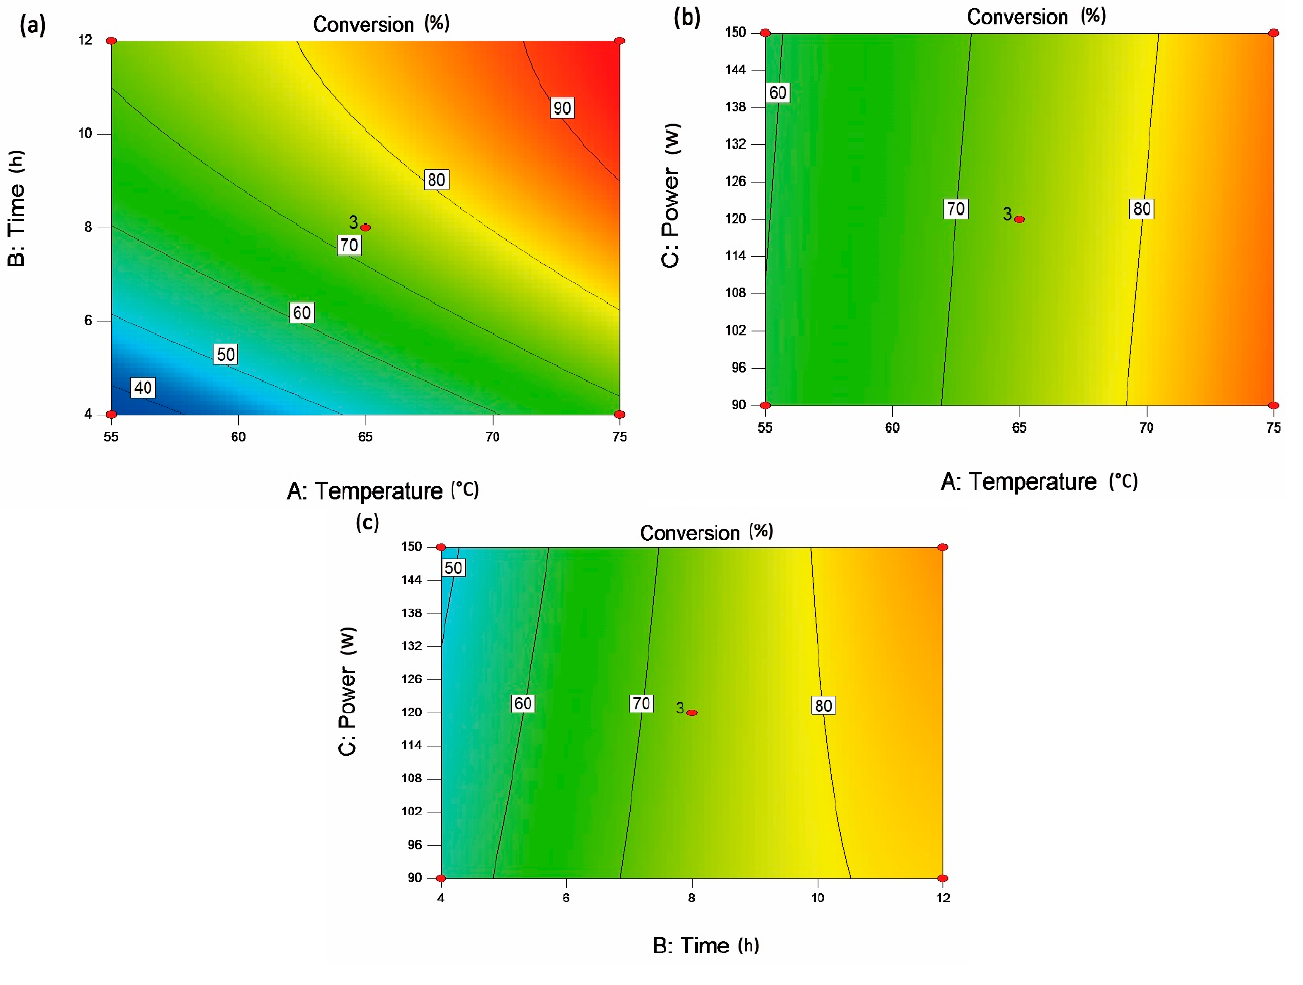
Figure 5. Contour plots show the different reaction behaviors ( a ) reaction temperature and reaction time with a fixed ultrasonic power of 120 W; ( b ) reaction temperature and ultrasonic power with a fixed reaction time of 8 h; and ( c ) reaction time and ultrasonic power with a fixed reaction temperature of 65 ◦ C. The numbers on the contours indicate the molar conversion of octyl cinnamate under specific reaction conditions. Table 3. Experimental and predicted values of the optimization